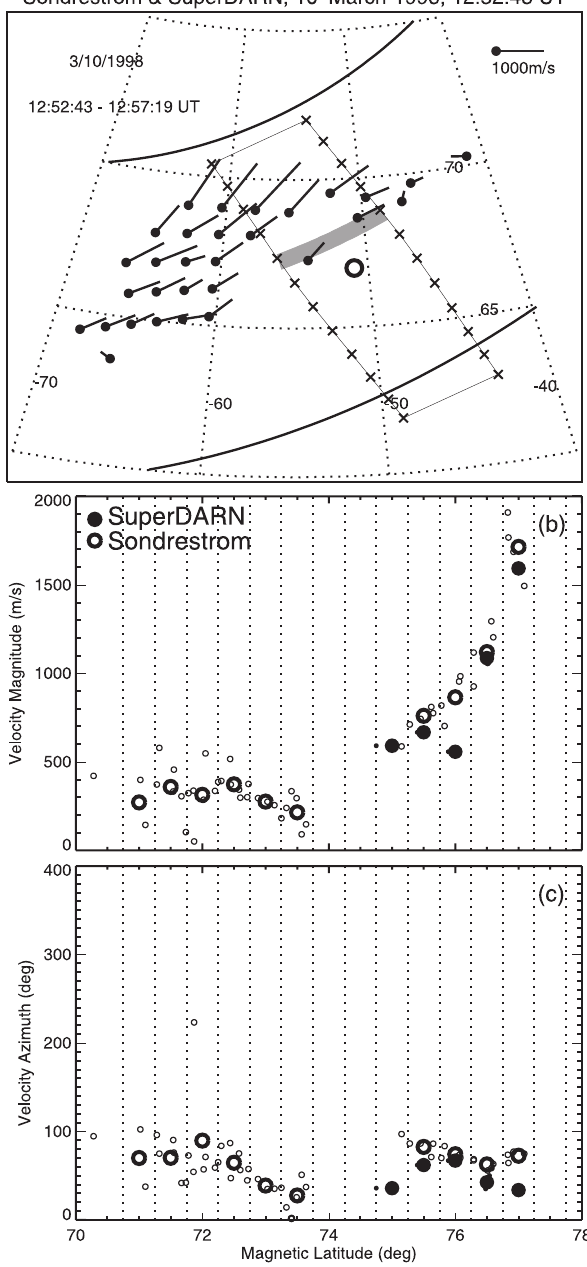
Fig. 7. SuperDARN and Sondrestrom data for 10 March 1998, 1252 UT. (a) A SuperDARN map of ionospheric plasma convection in the standard format. The area of the Sondrestrom ISR measure- ments is shown by crosses. L-shell aligned stripe represents one of the “boxes” for which the ISR and HF radar data were averaged and compared. (b) Meridional profiles of plasma flow magnitude. Small open circles and dots indicate the original ISR and Super- DARN data, large open circles and large solid circles indicate aver- aged values. (c) Meridional profiles of plasma flow azimuth. Sym- bol meaning is the same as for (b). Azimuth was counted clockwise from the direction of geographic